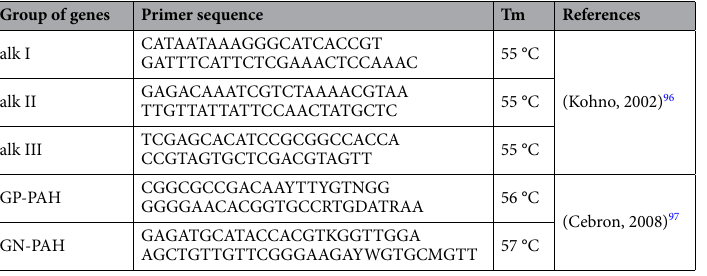
Polymerase, 1 × SYBR Green Buffer, 2.5 mM MgCl 2 , 200 µM of each dNTP, 0.2 µM of each primer and 1 µl of DNA template. Standard curves were generated for bacteria using serial DNA dilutions from Bacillus pumilus